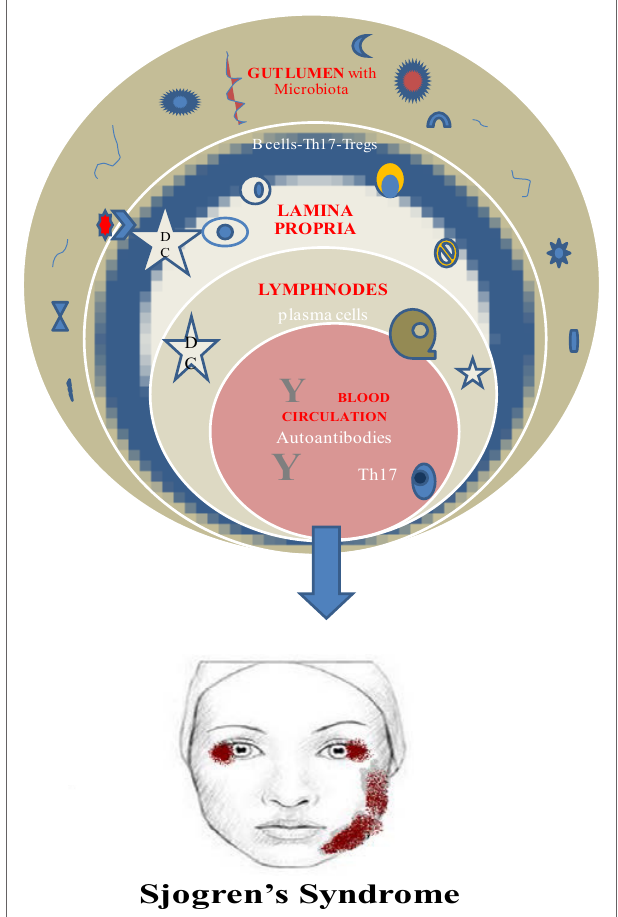
FiGURe 1 | Microbiome and Sjogren’s